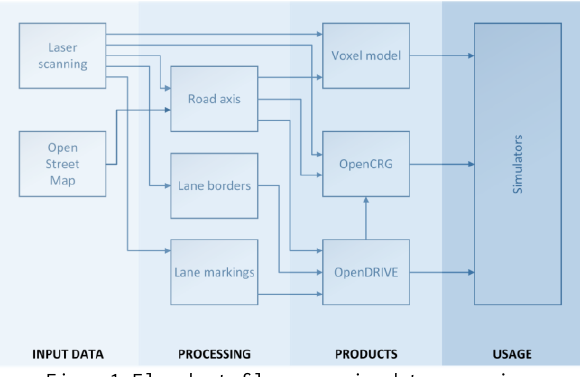
Figure 1. Flowchart of laser scanning data